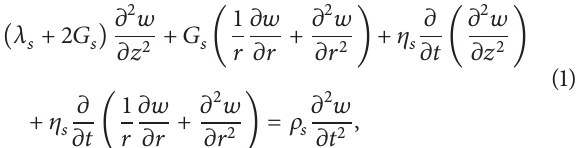
Figure 1: Schematic of pile-soil interaction model.